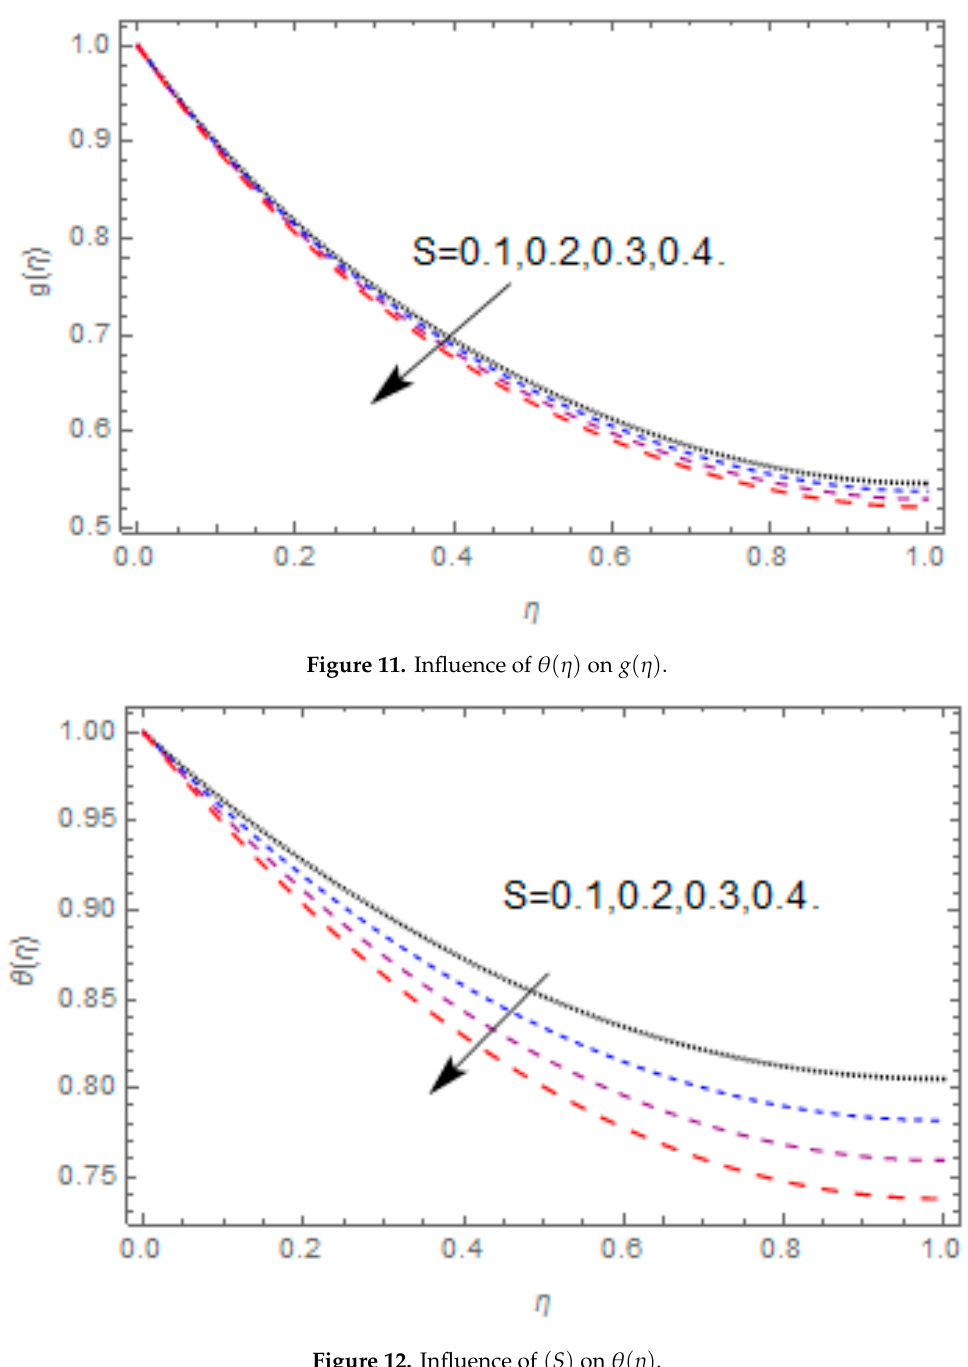
Figure 12. Influence of ( S ) on θ ( η )